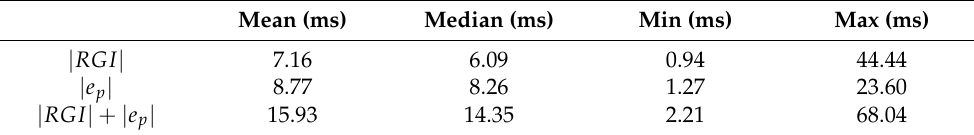
Table 5. Statistical metrics for | RGI | , | e p | , and their sum.